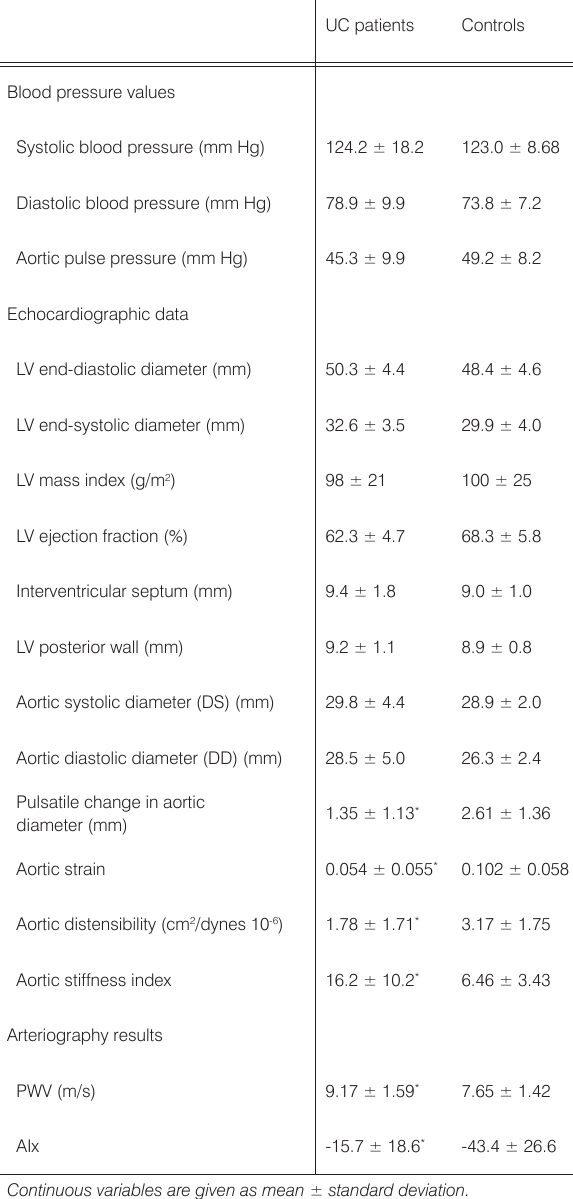
Table 2. Blood pressure and echocardiographic data of patients with ulcerative colitis and that of